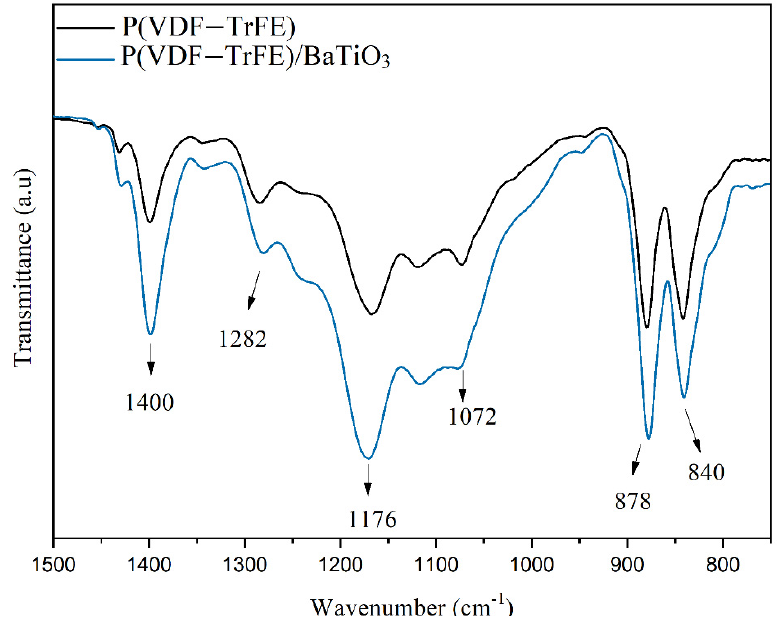
Figure 6. FTIR spectra of P(VDF-TrFE) and P(VDF-TrFE)/BaTiO 3 in the wavenumber ranging from 1500 to 800 cm − 1 .